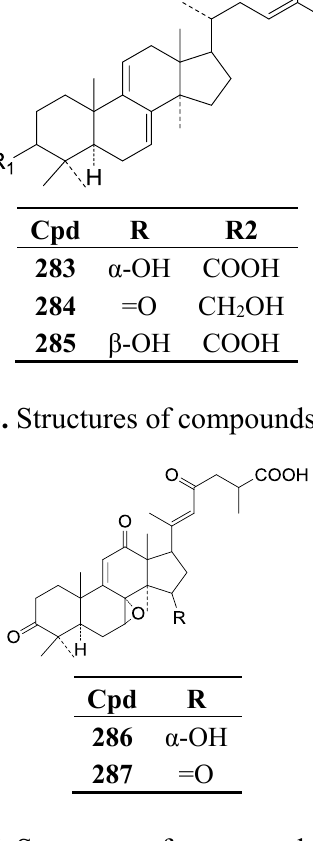
Figure 35. Structures of compounds 288 – 307